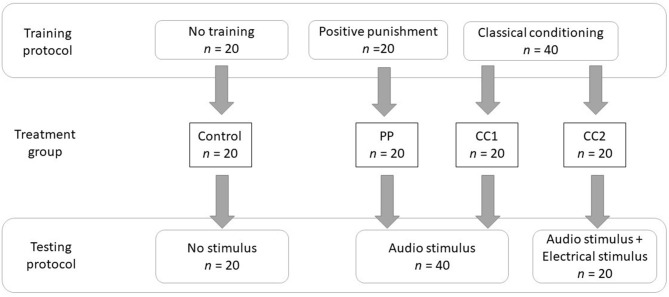
The experimental methodology describing the training and testing protocols of four treatment groups.